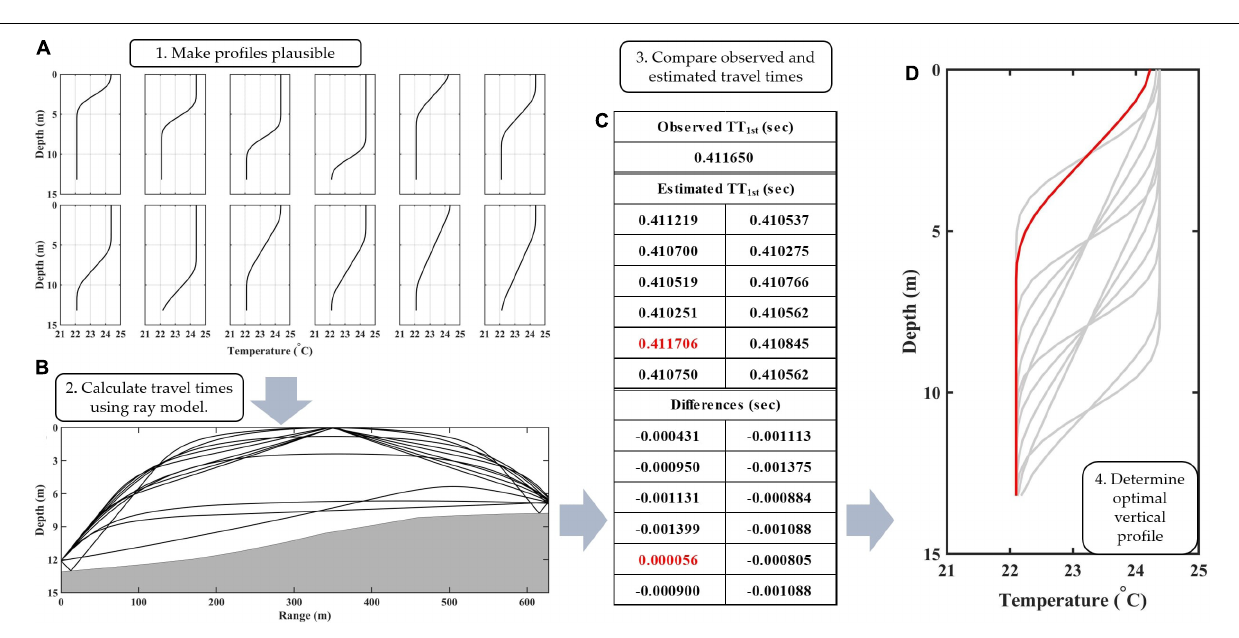
at depths of 1, 3, 5, 6.5, 10, 15, and 22 m; thus, the model can represent successive vertical temperature changes in shallow gridded SST data (MGDSST) of the Japan Meteorological Agency were used for surface relaxation with a time scale of 3 days.